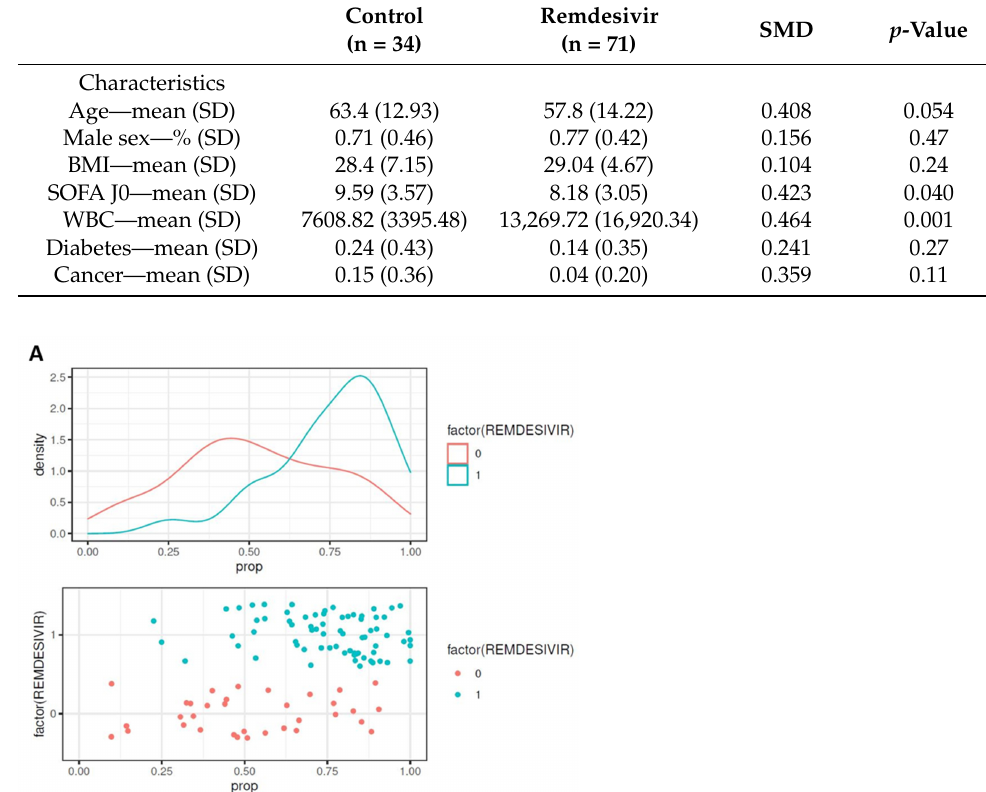
Table 2. Comparison of patients on invasive ventilation with controls.